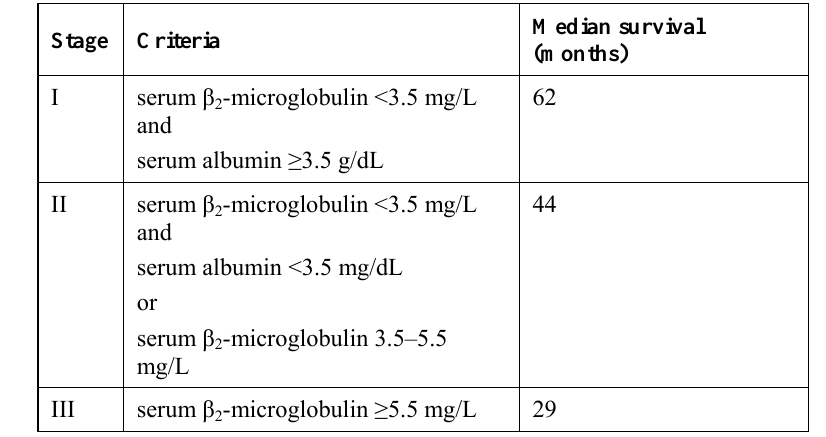
Staging systems for multiple myeloma: Durie-Salmon staging system (a) [90] and the International stating system (b) [91]. Durie-Salmon staging